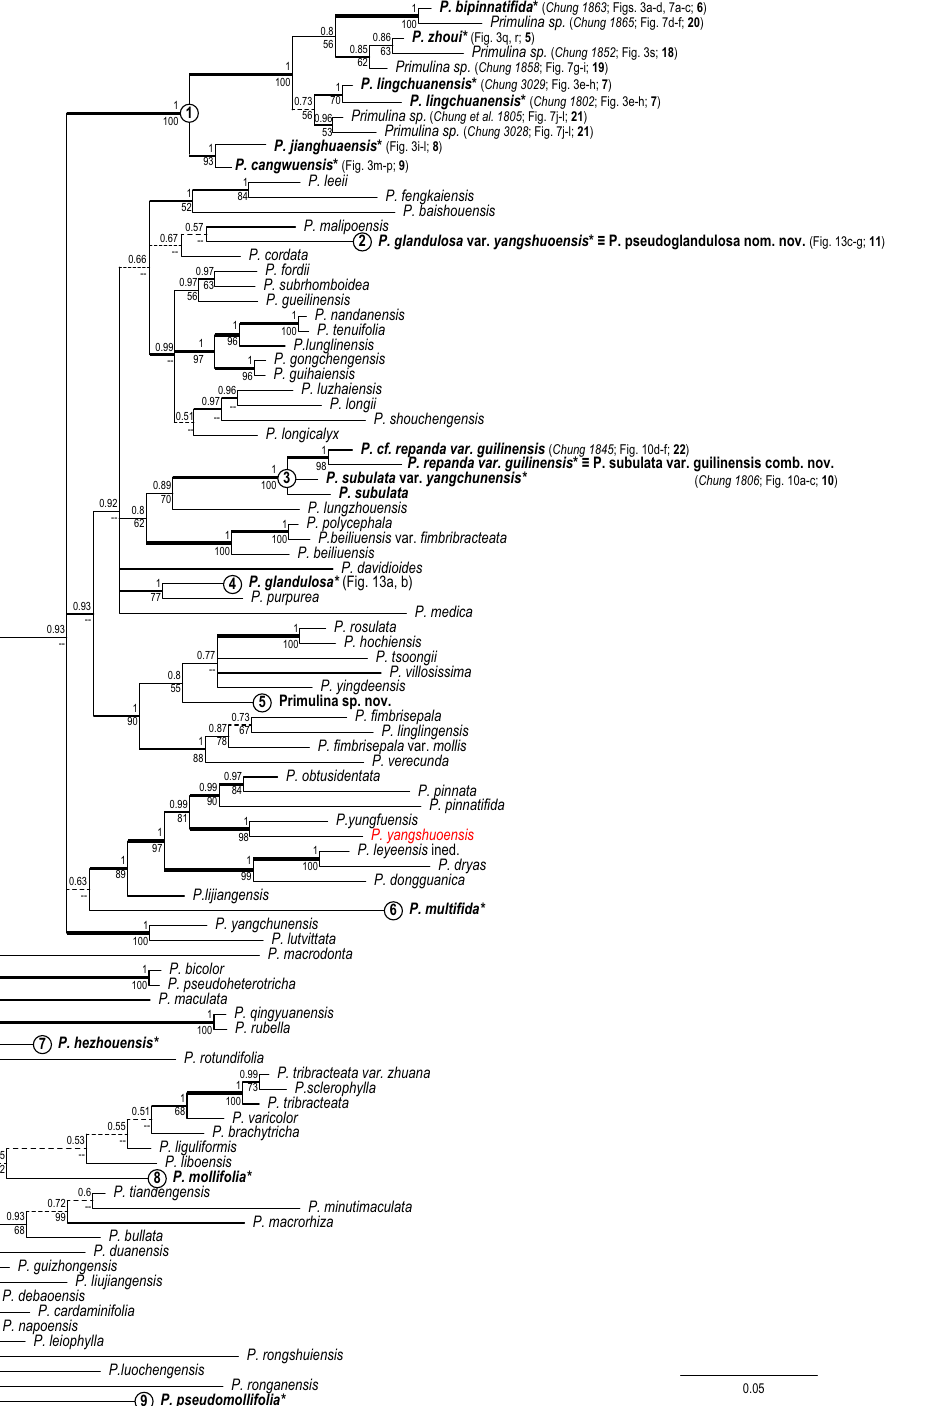
Fig. 4 Bayesian majority‑rule consensus tree with mean branch length based on the combined ITS and chloroplast ( trnL ‑ F and trnH ‑ psbA ) DNA sequences. Bayesian posterior probability (PP; > 0.50) and ML bootstrap support values (ML; > 50%) are shown above and below the branch around the corresponding node. Thickest clades denote both PP and ML higher than 0.95. Thick clades denote only PP > 0.50. Dashed branches denote clades with PP < 0.75. Species of Chiritopsis‑like Primulina are shown in bold face, with * indicating materials from type locality. Numbered circles denote clades containing Chiritopsis‑like Primulina